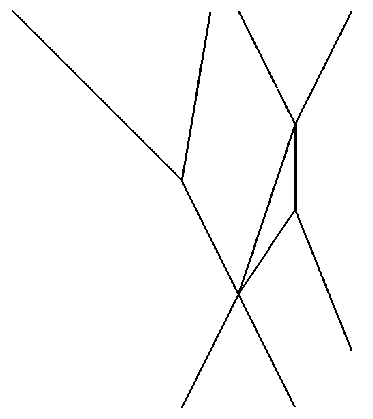
Figure 2 . A more complicated scattering process in